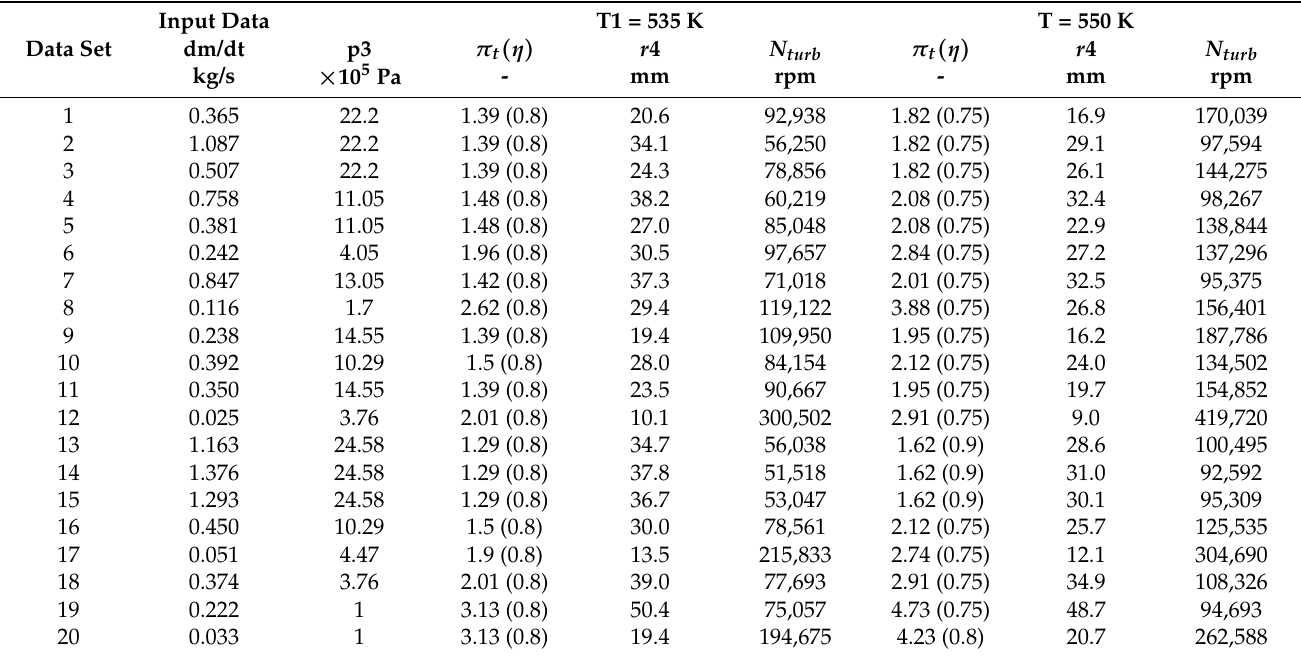
Table A3. Turbine radius r4 and rotational speed N turb for single expansion, based on the data sets from industry in Tables A1 and